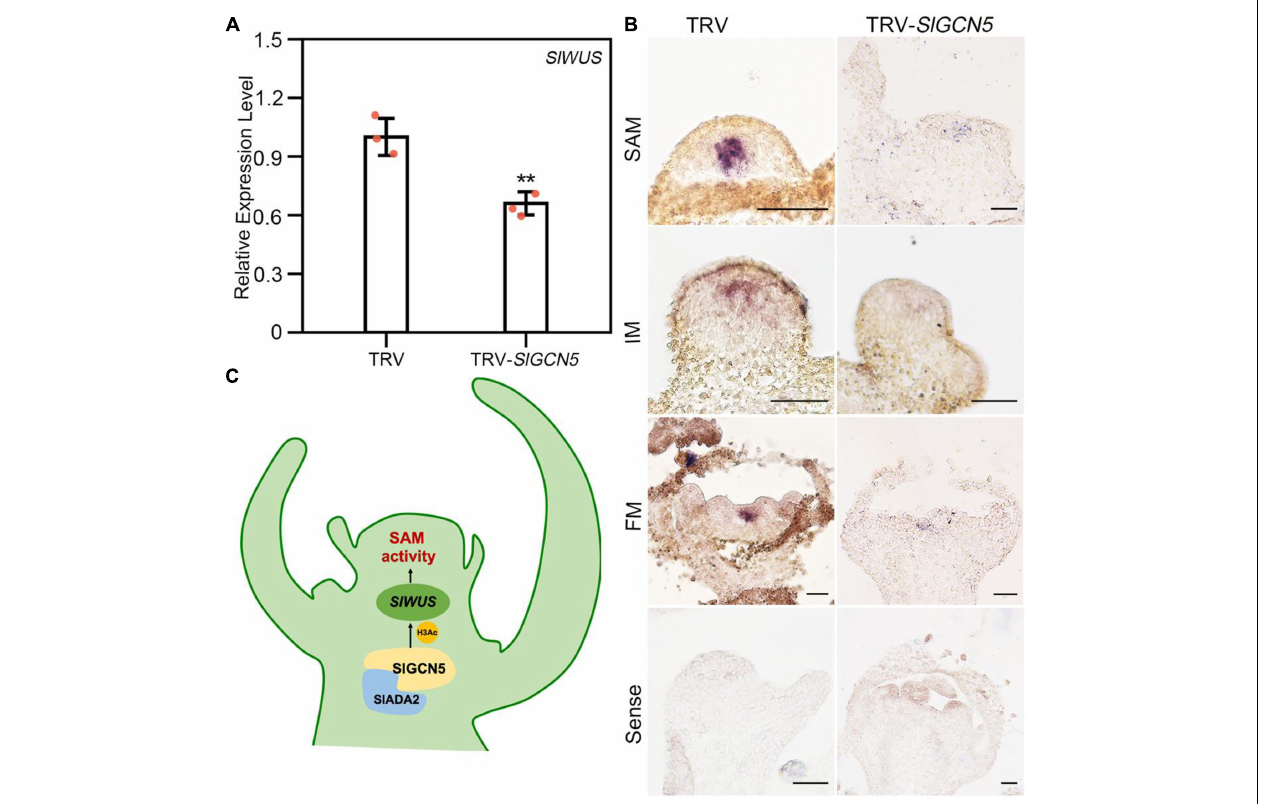
FIGURE 5 | SlGCN5 positively regulates SlWUS in tomato. (A) qRT-PCR analysis of SlWUS expression level in SAM. The error bar represents SD of three biological replicates. The asterisks indicate significant differences between TRV and TRV- SlGCN5 (** p < 0.01). (B) Expression of SlWUS mRNA in TRV control and TRV- SlGCN5 plants by in situ hybridization. Scale bars = 50 µ m. (C) Model: SlGCN5 together with SlADA2a and SlADA2b could form HAT complex, which positively regulate SlWUS to ensure the proper development of